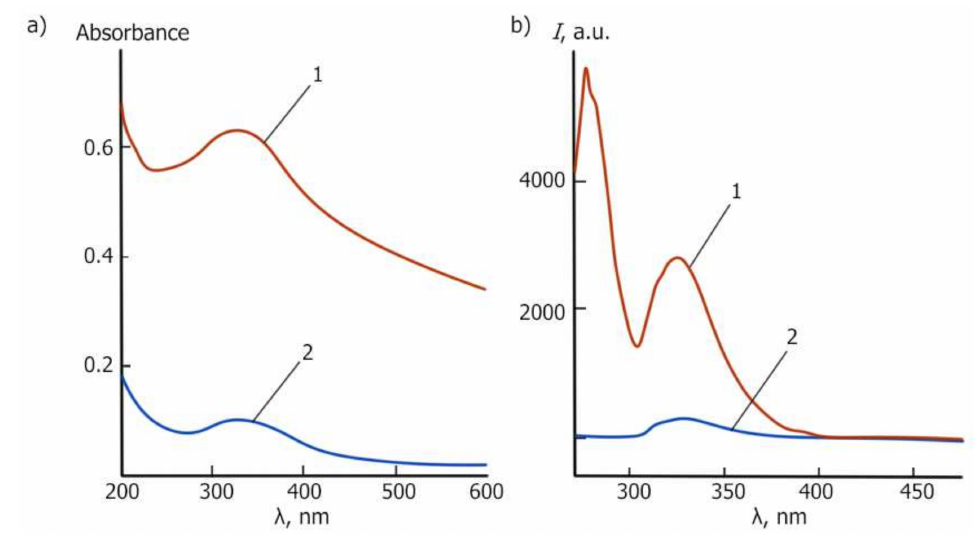
Figure 6. Spectra of the CeO 2 NPs stabilized using maltodextrin with an average size equal to 2–5 nm (PXRD) (curve 1) and the standard CeO 2 NPs sample with an average size equal to 40 nm (PXRD) (curve 2): ( a ) UV-vis spectra of 20 mg/% dispersions in methanol; ( b ) fluorescent spectra of 5 mg/% dispersion, λ ex = 265 nm.